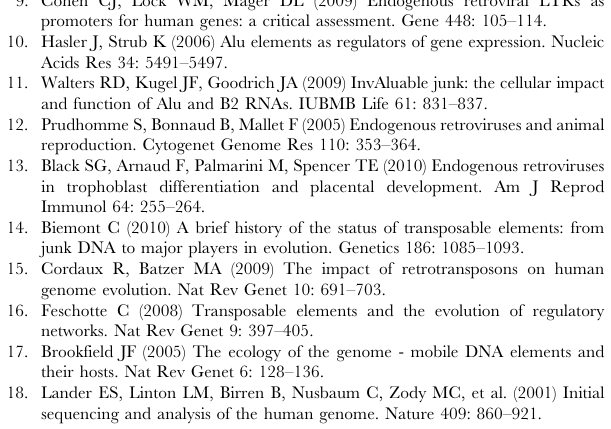
Figure S2 The relationship between gene size and exon density in human. (A) The negative association between gene size and exon density. (B) The linear regression between gene size and the inverse of exon density. r is the correlation coefficient. Figure S3 Identification of outlier genes by controlling gene size and exon density. In any given species, all genes $ 10 kb were divided into 25 subsets based on both gene size and exon density and were put into a 5 x 5 matrix. For genes in each subset, upper/lower outliers were identified by taking the top or bottom 10% genes with the most extreme TE density. The final set of upper/lower outlier genes is collected by merging the upper/ lower outliers from each subset, for which the variations of both gene size and exon density are controlled. Figure S4 Chromosomal distribution of SUOs and SLOs in human. The short red lines along the left side of each chromosome show the chromosomal locations of SLOs. The short blue lines along the right side of each chromosome show the chromosomal locations of SUOs. Figure S5 The relationship between the number of SUOs/SLOs on human chromosomes and the chromo- some size. Results for SUOs and SLOs are shown in (A) and (B), respectively. In both (A) and (B), the x-axis shows the genomic coverage of each chromosome in percentage, and the y-axis shows the total number of SUOs/SLOs on a given chromosome. Figure S6 Correlation analysis of the TE composition of SUOs between human and mouse. Results for LINE, SINE, LTR retroelement and DNA transposon are shown as linear regression plot in (A), (B), (C) and (D), respectively. In each plot, each open circle represents an SUO gene and its location is determined by the density of the corresponding TE class of the SUO orthorlogs in the two species. The line across the data points in each plot represents the regression line, and r is the correlation coefficient. Figure S7 Correlation analyses of G + C content vs. LINE/SINE composition of SUOs in human. Results for LINE and SINE are shown in (A) and (B), respectively. The x-axis shows the proportion covered by LINEs/SINEs relative to all TEs in each SUO gene. The y-axis shows the average G + C content of